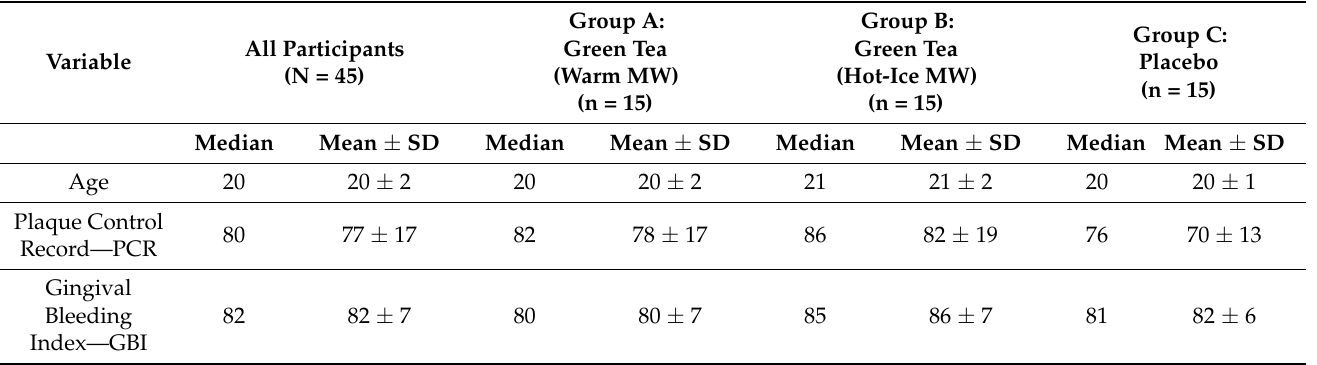
Table 1. Medians, means and standard deviations of the age and the baseline Plaque Control Record and Gingival Bleeding Index in the total sample (N = 45) and the three mouthwash (MW) groups (n = 15).